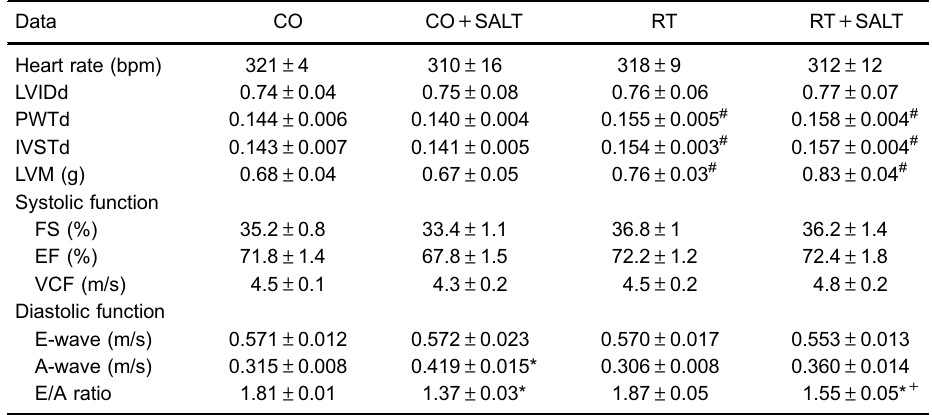
Table 2. Heart rate, cardiac structure, systolic and diastolic left ventricle (LV) function by